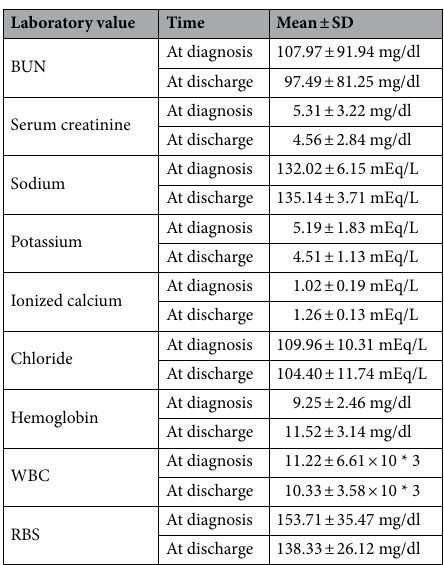
Table 2. Laboratory values for AKI patients at JMC (n = 203). BUN, blood urea nitrogen; WBC, white blood cell; RBS, random blood sugar.